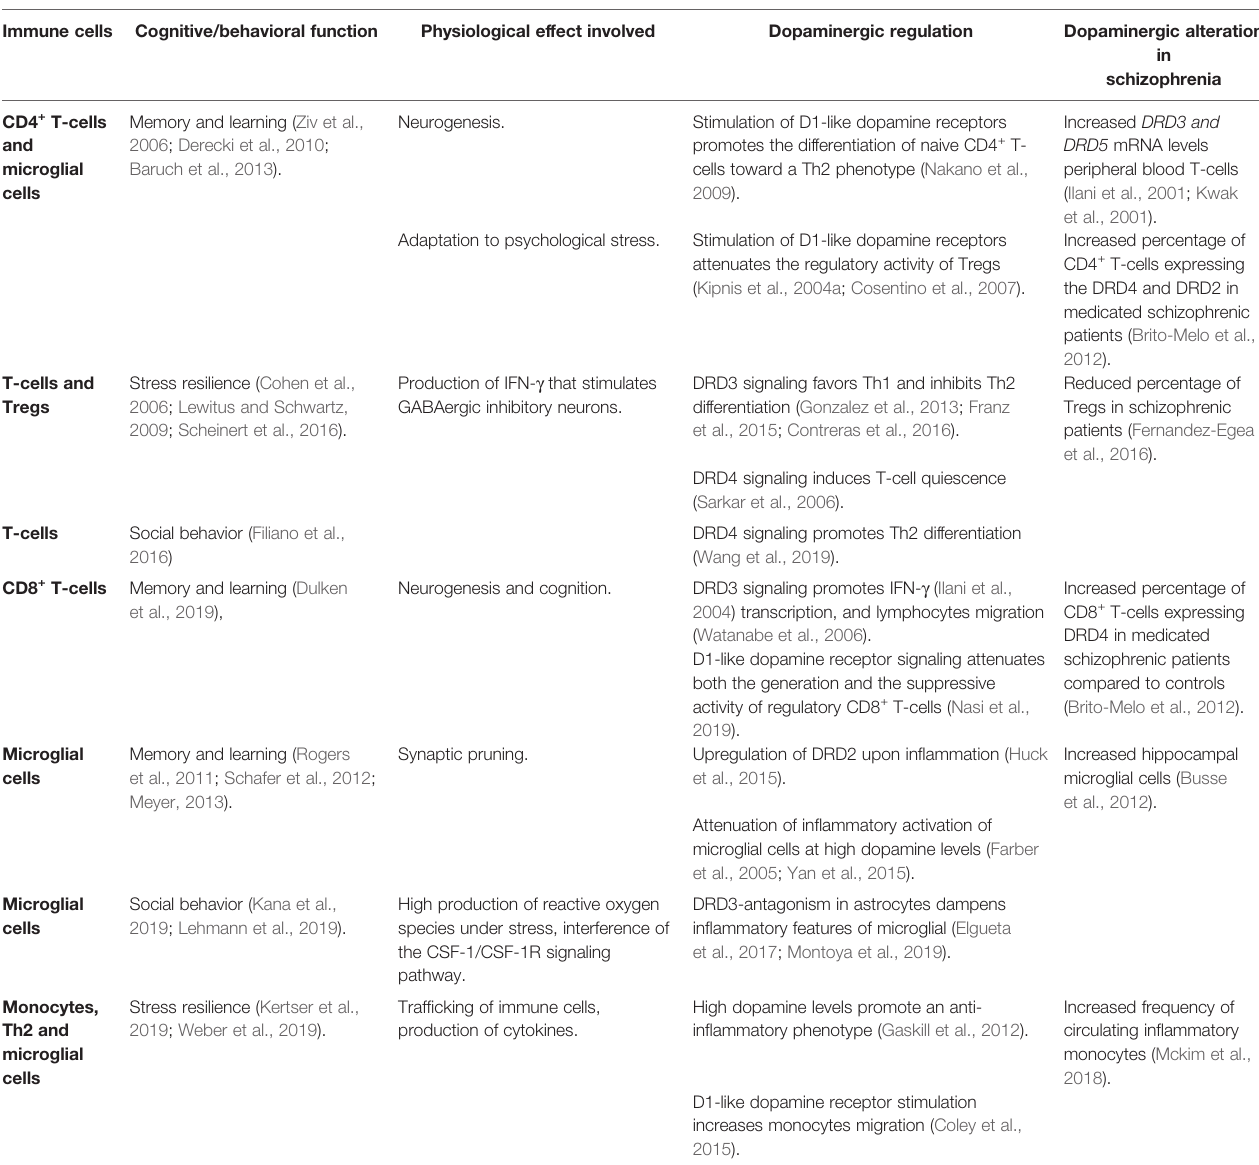
TABLE 1 | Dopaminergic regulation of the immune system associated with cognitive/behavioral